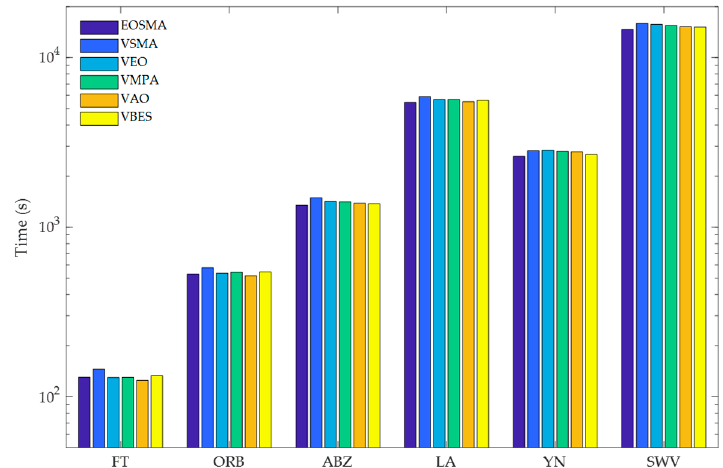
Figure 5. Execution time of six algorithms running 20 times.